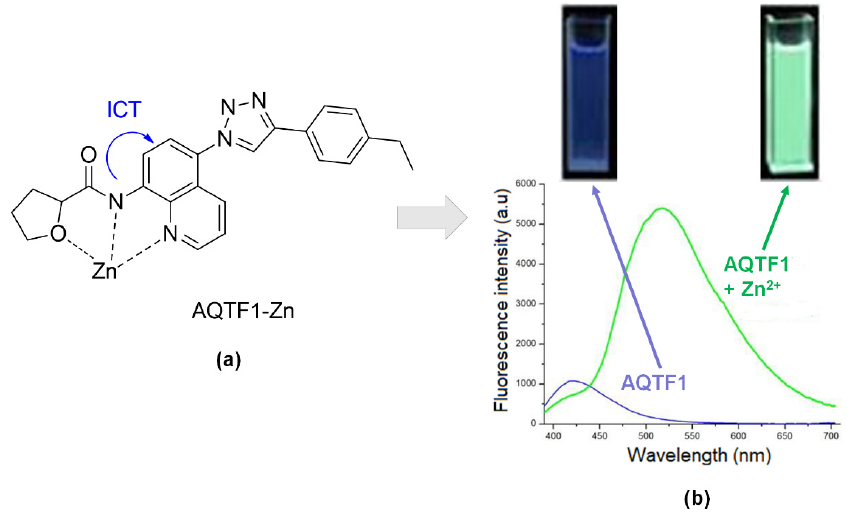
Figure 13. ( a ) Complexation of AQTF1-Zn. ( b ) Naked eye color changes under visible fluorescence and their fluorescence intensity spectra, blue (without binding with Zn 2+ ) and green (upon binding with Zn 2+ ).